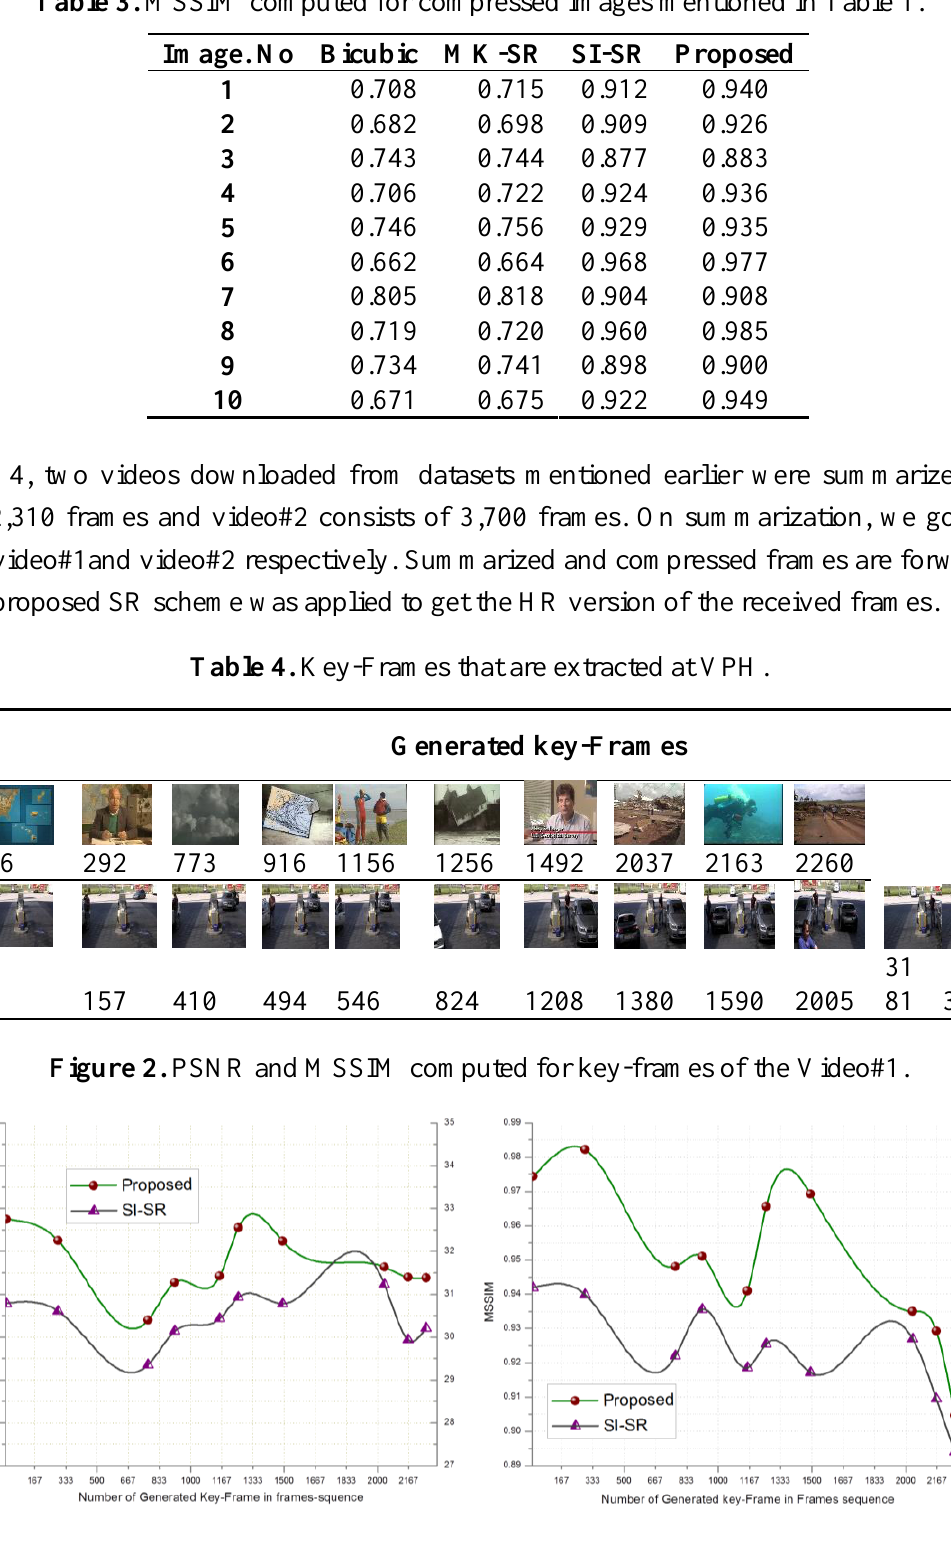
Table 3. MSSIM computed for compressed images mentioned in Table 1.